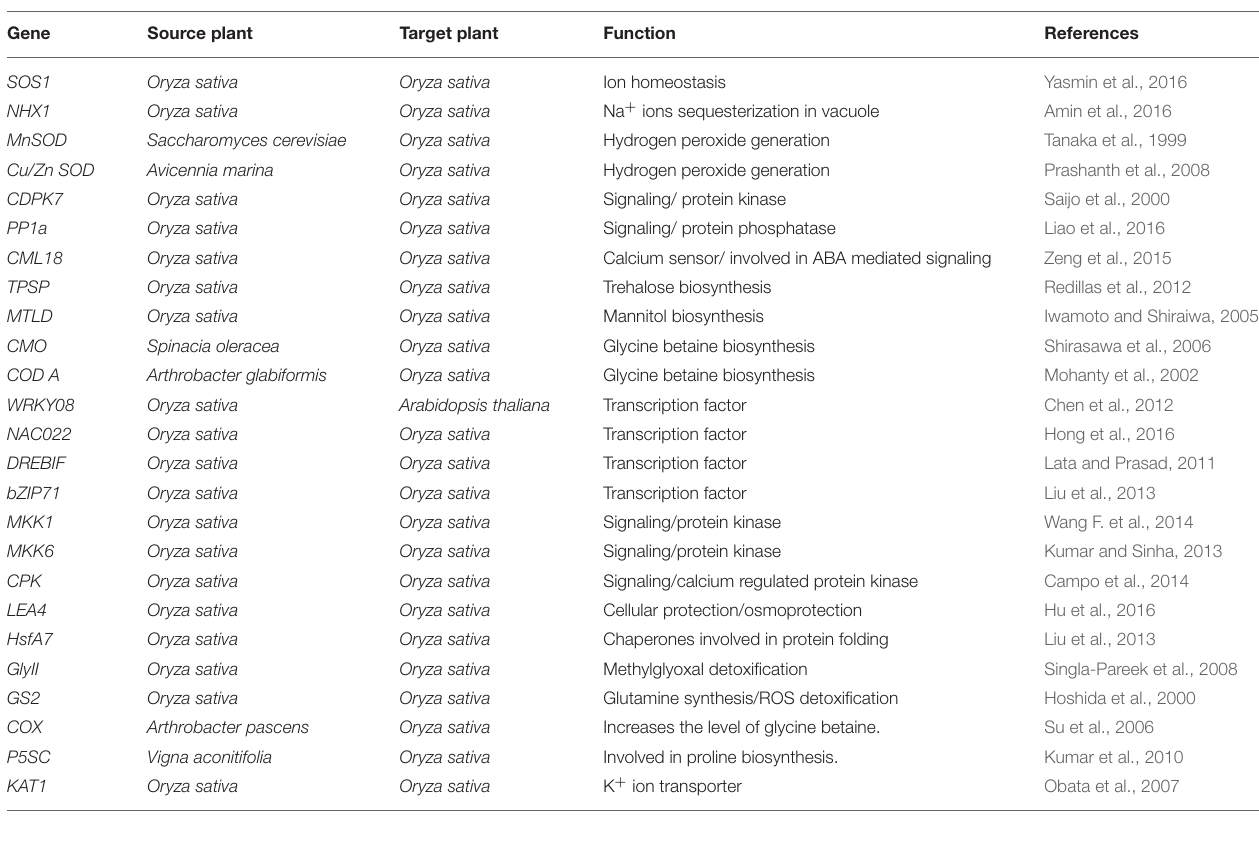
TABLE 1 | Summary of the genes used for improvement of salinity tolerance in rice using transgenics approach.